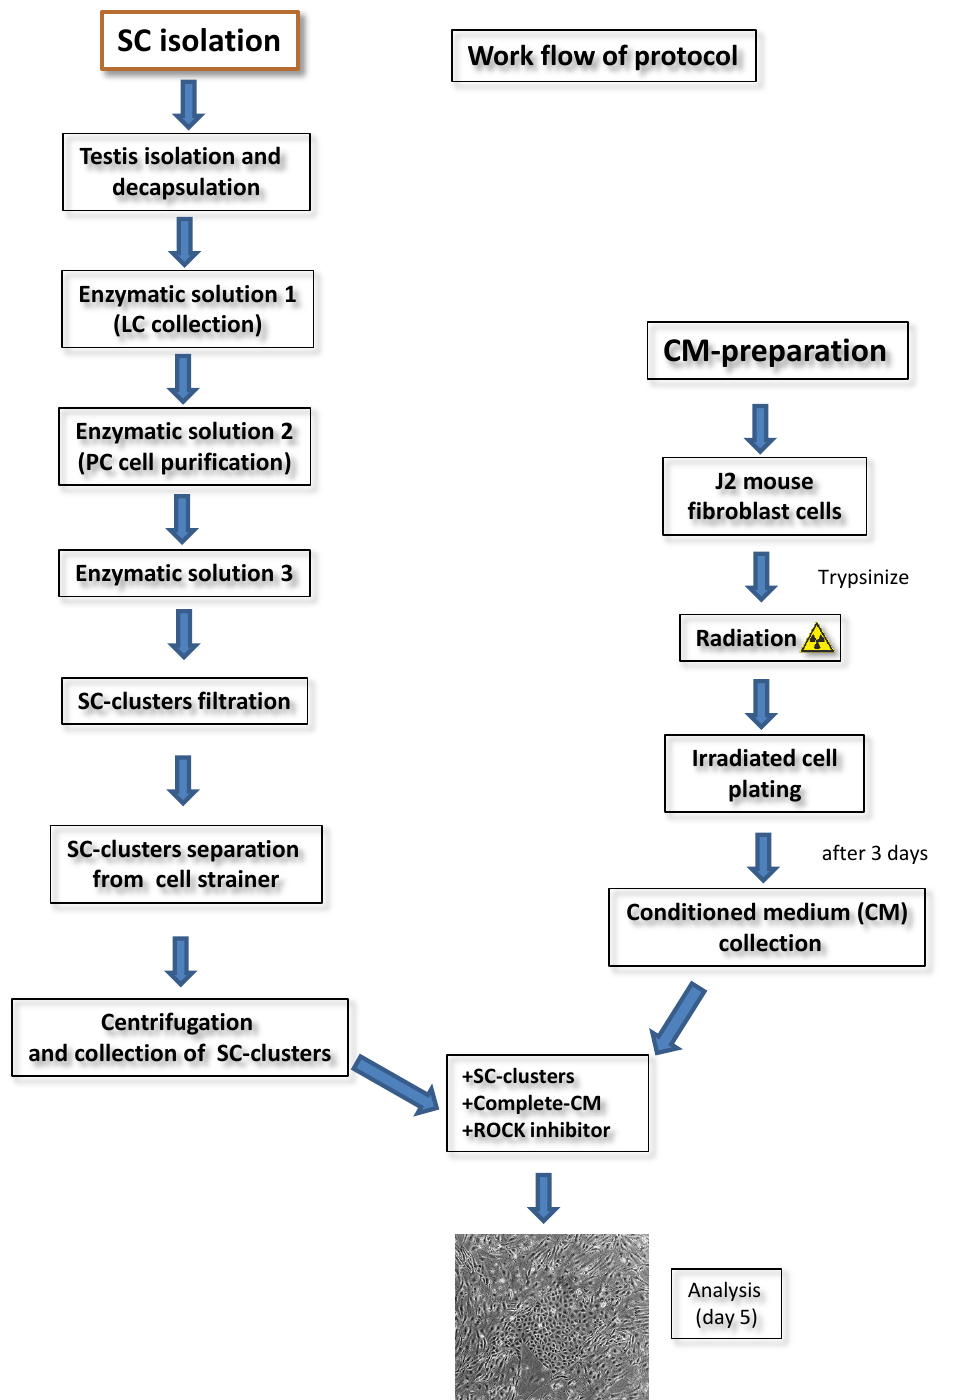
Figure 3. An overview of the CR method for the isolation of adult rat SCs is